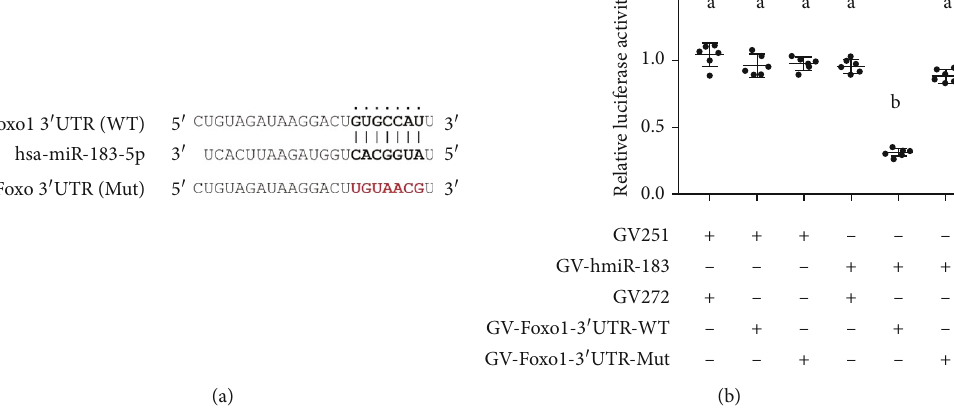
Figure 8: miR-183-5p directly targets Foxo1 3 ′ UTR. (a) The binding site of miR-183-5p and the position 226-242 of Foxo1 3 ′ UTR wild type (WT) and mutant type (mut). (b) miR-183-5p ectopic expression signi fi cantly inhibited luciferase activity of the wild-type Foxo1 3 ′ UTR reporter plasmid in comparison with the mutated counterpart. Groups labelled with di ff erent letters are statistically di ff erent from each other ( ∗ p < 0 : 05 ). Di ff erences between groups were analyzed for statistical signi fi cance by ANOVA with Fischer ’ s probable least- square di ff erence post hoc